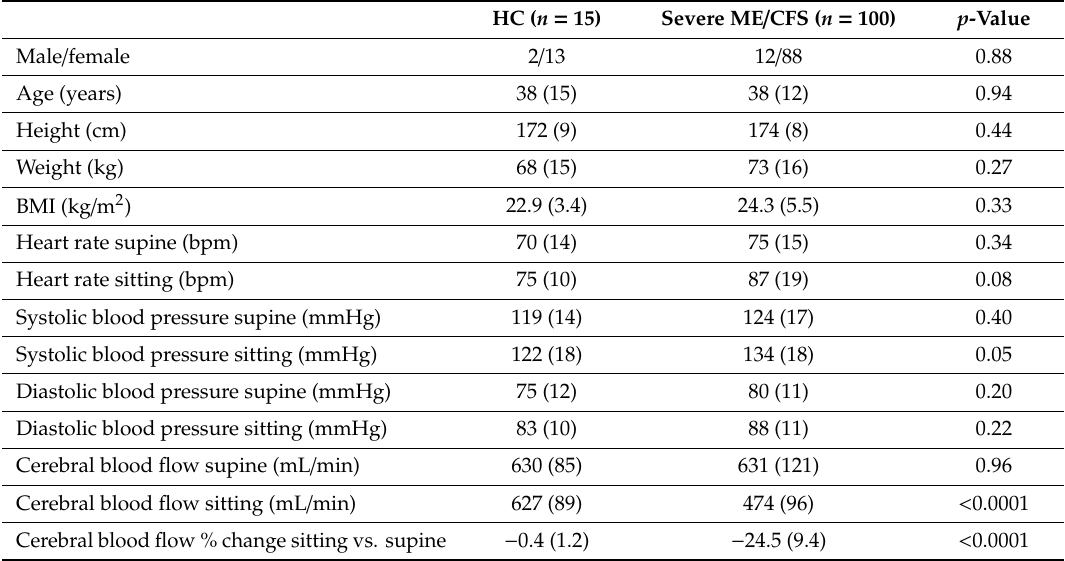
Table 2. Demographic features and orthostatic stress test results in healthy controls and severe ME / CFS